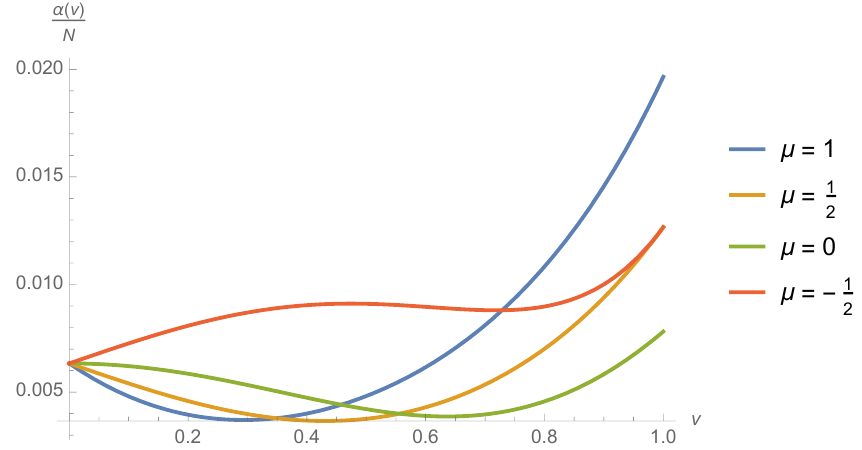
Figure 5 . We plot (cid:11) ( v ) for various values of (cid:22) . All curves start with the same value at v = 0 while they end with di(cid:11)erent values at v = 1.